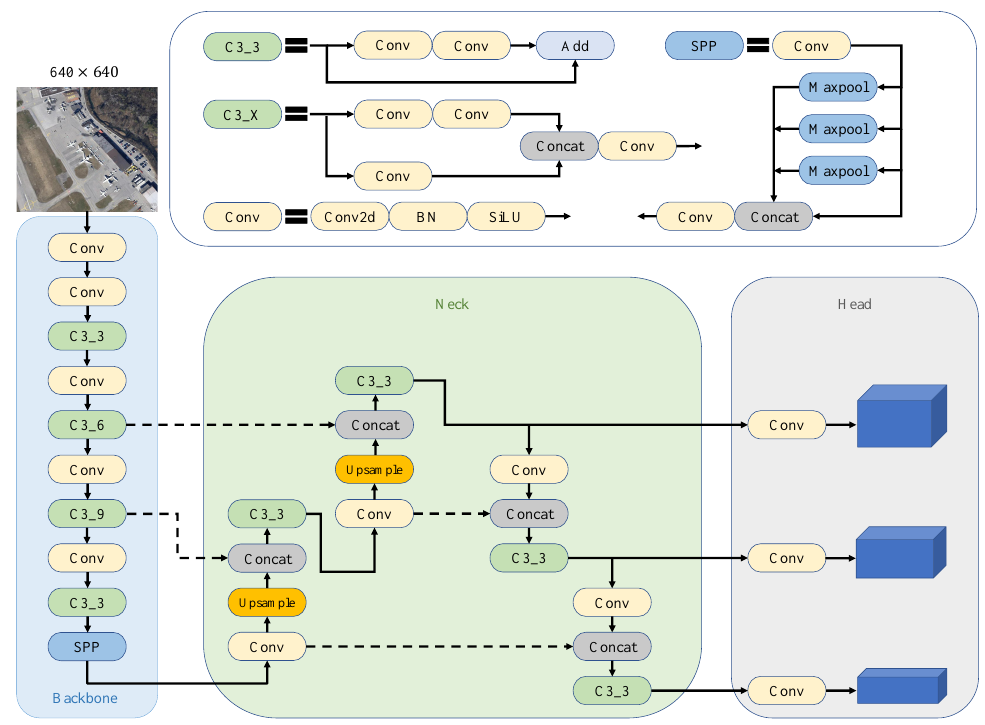
Figure 1. The conventional YOLOv5 algorithm